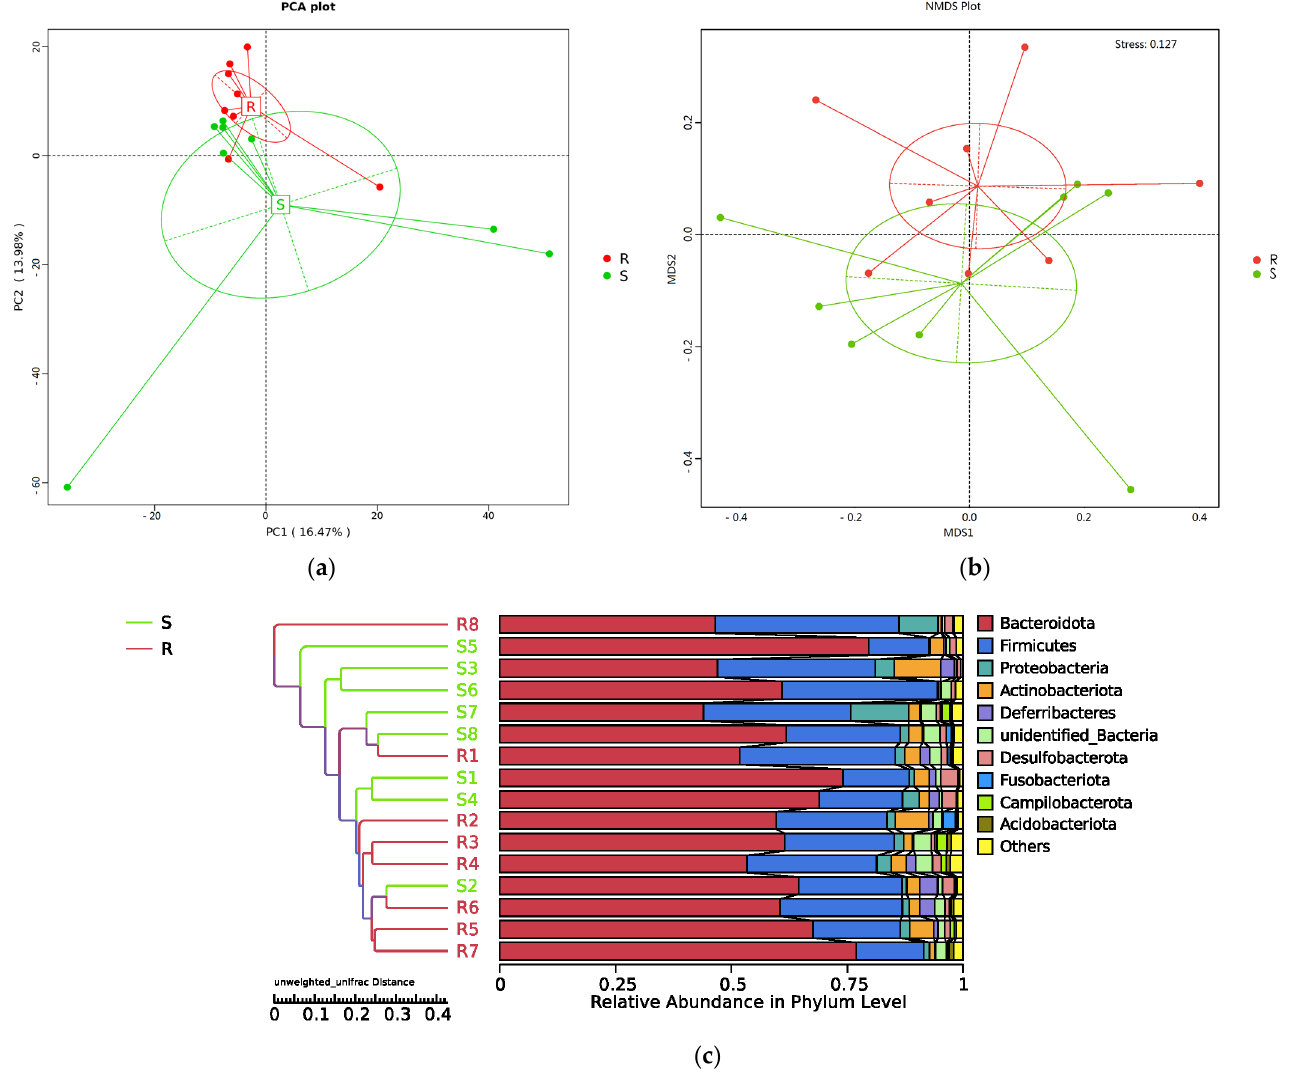
Figure 3. Beta diversity analysis of cecal microbiota ( n = 8). ( a ) Principal component analysis (PCA). ( b ) Non-metric multidimensional scaling (NMDS). ( c ) Unweighted pair-group method with arithmetic means (UPGMA) clustering tree structure. R = S. enteritidis -resistant chicks; S = S. enteritidis -susceptible chicks.